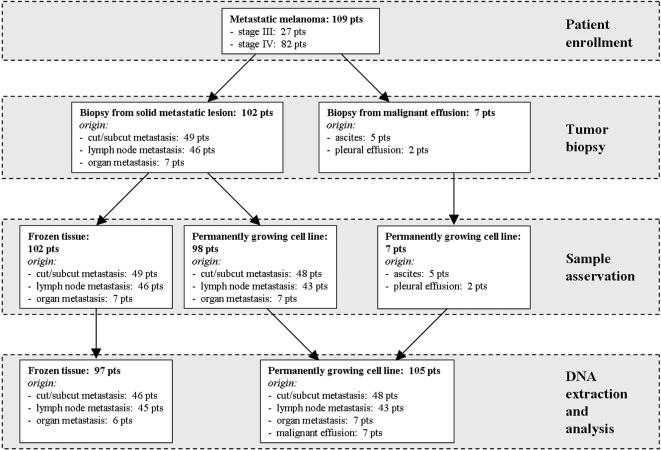
Schematic presentation of the study flow.